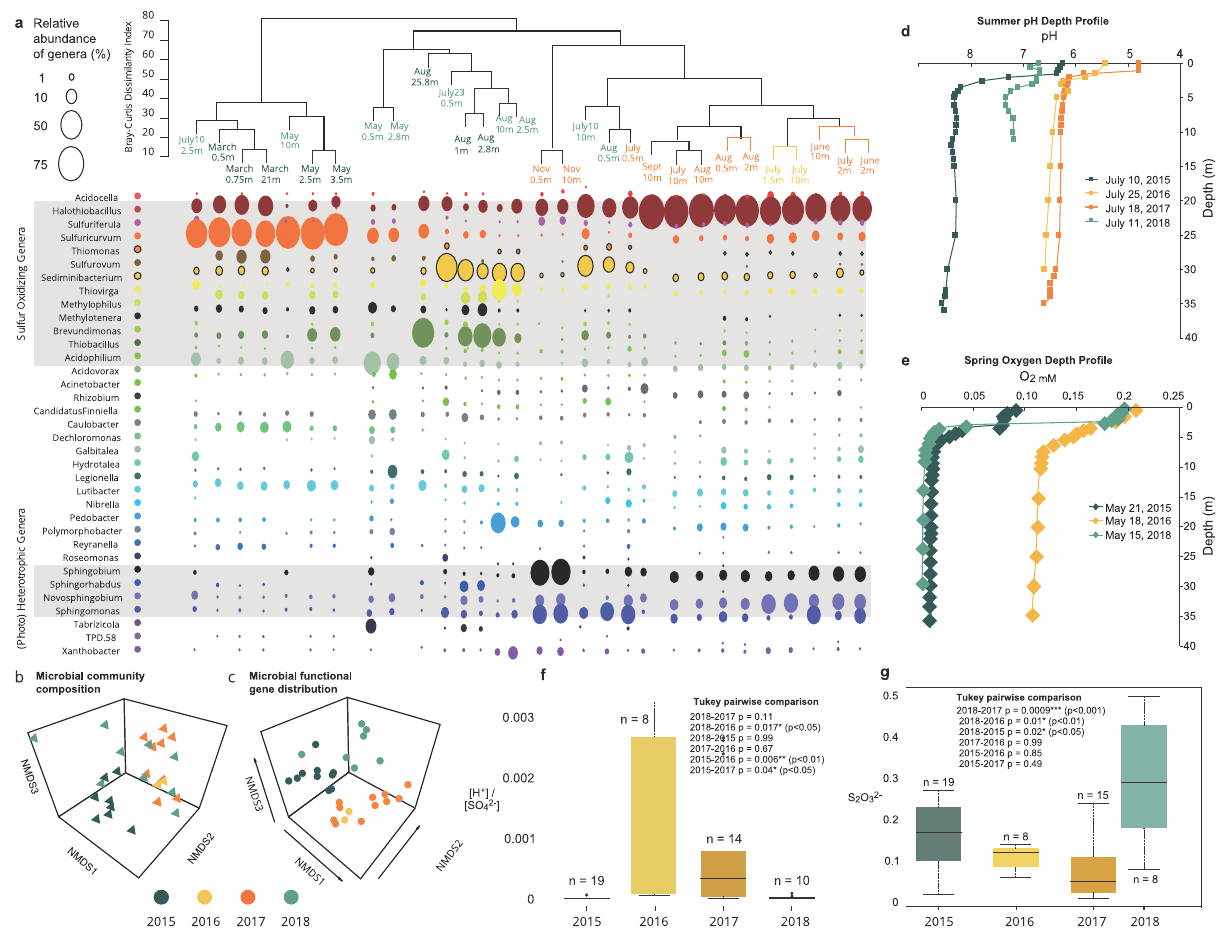
Fig. 1 | Microbial community and aqueous geochemical distributions over time.a Bray Curtis dissimilarity clustering of microbial communities and bubble plot representation of relative abundances of bacterial genera (showing only genera present at >1% within at least two samples). Non-metri c dimensional scaling (NMDS) ( k =3) representation of the microbial community composition b , and functionality ( c ) (derived as the relative abundance of sulfur cycling, nitrogen cycling, hydrogen cycling, carbon fi xation, photosynthetic and aerobic respiration genes (Supplementary Dataset 5), ( n =30) stress=0.065, non-metric fi t=0.996, linear fi t, R 2 =0.97). d The pH depth pro fi les from July 2015 to